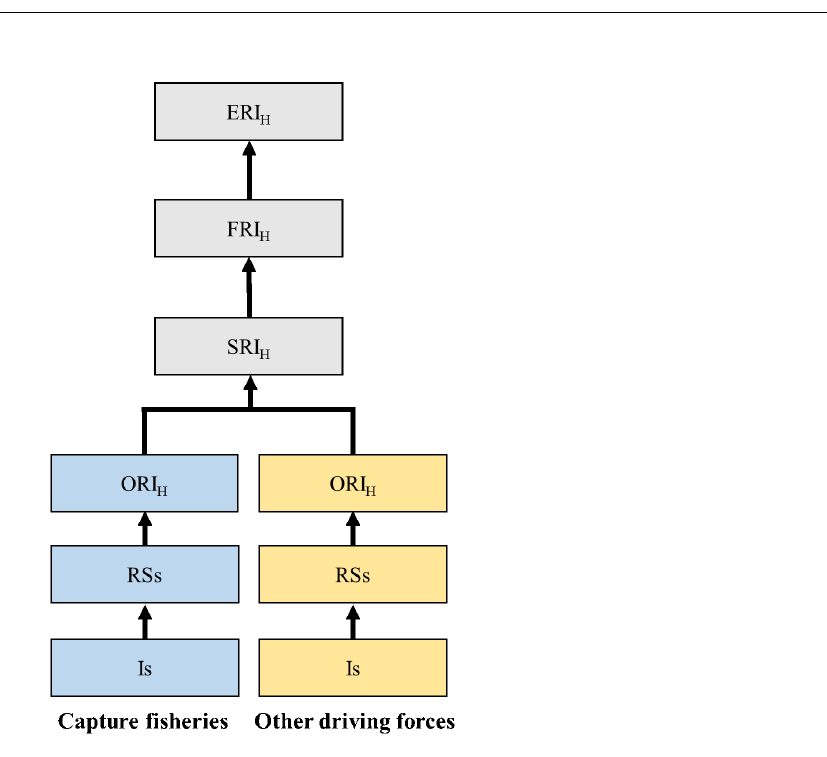
Figure 4. An example nested structure of the risk indices considering only habitat quality. ORI H , SRI H , FRI H , and ERI H indicate an objective risk index for habitat quality, species risk index for habitat quality, fishery risk index for habitat quality, and ecosystem risk index for habitat quality, re-